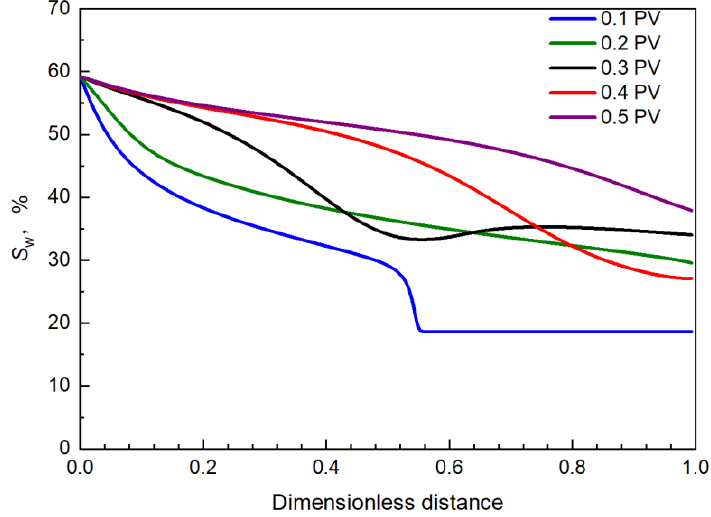
Figure 16. Water saturation change along the flow when water − oil viscosity ratio is 0.1.